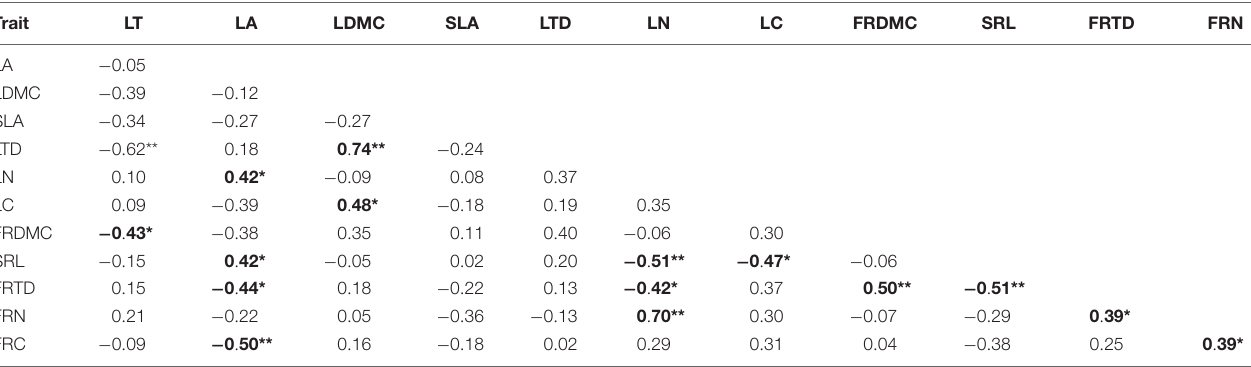
TABLE 3 | Matrix of Pearson’s correlation coefficients for the relationships between leaf and fine root traits in perennials ( n = 32). Trait LT LA